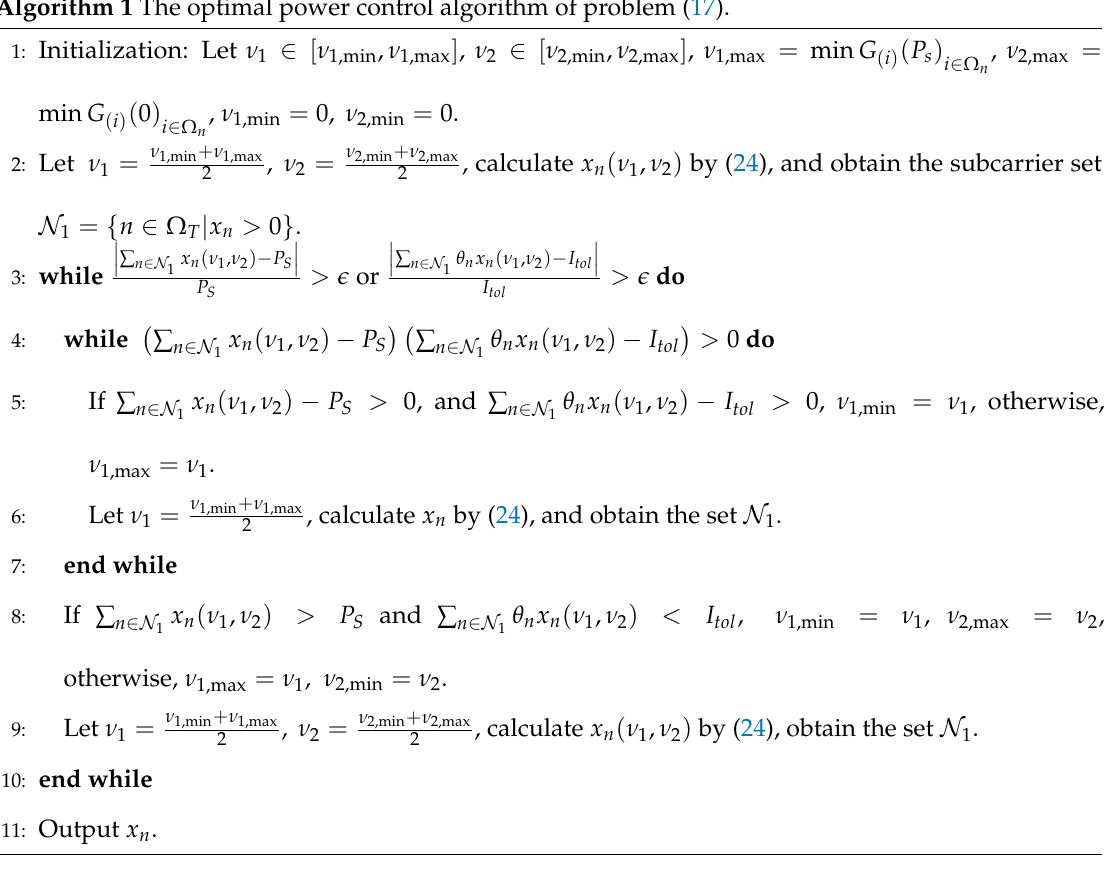
Algorithm 1 The optimal power control algorithm of problem